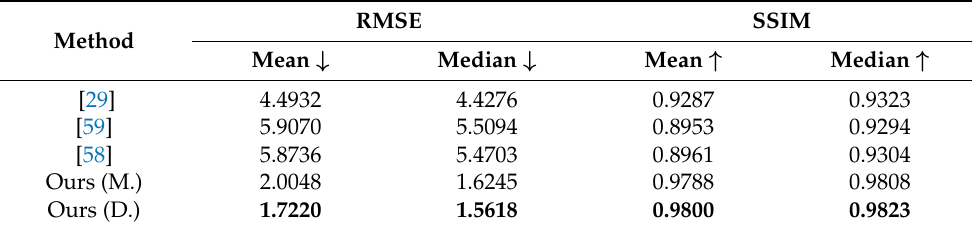
Table 1. Quantitative evaluation of multi-view highlight removal on the Laboratory Captured Dataset.